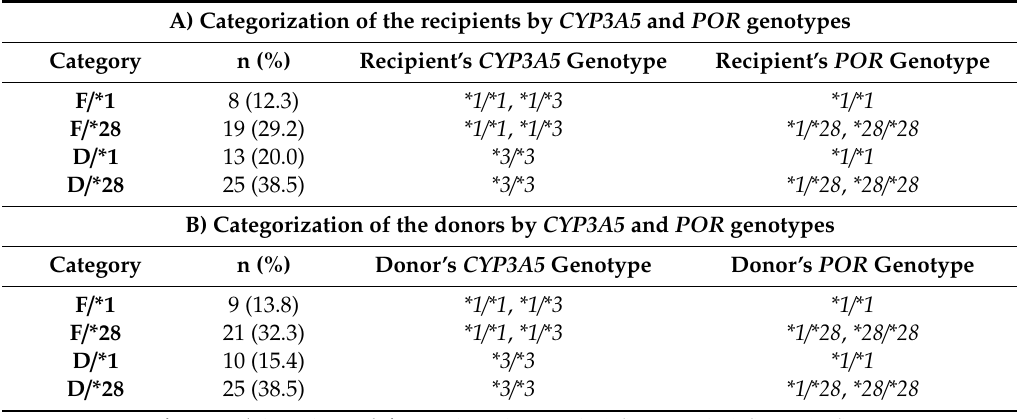
Table 3. Demographics of the recipients and donors by the combination of CYP3A5 and POR genotypes. A) Categorization of the recipients by CYP3A5 and POR